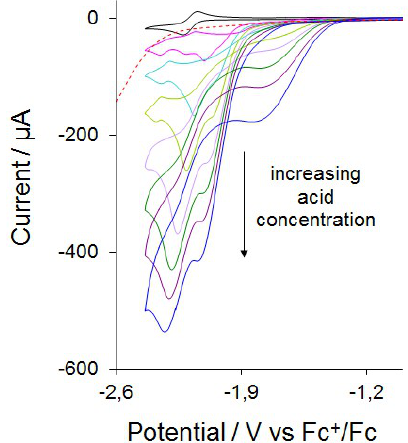
Figure 5. CVs of [Fe 2 (CO) 4 ( κ 2 -dppn)( µ -edt)] ( 3 ) in the absence of acid and in the presence of 1–7 equivalents of CF 3 CO 2 H (in MeCN, 1 mM solution, supporting electrolyte [NBu 4 ][PF 6 ], scan rate 0.1 V · s − 1 , glassy carbon electrode, potential vs. Fc + /Fc). Response of 10 equivalents of CF 3 CO 2 H alone is shown with the red dotted line.